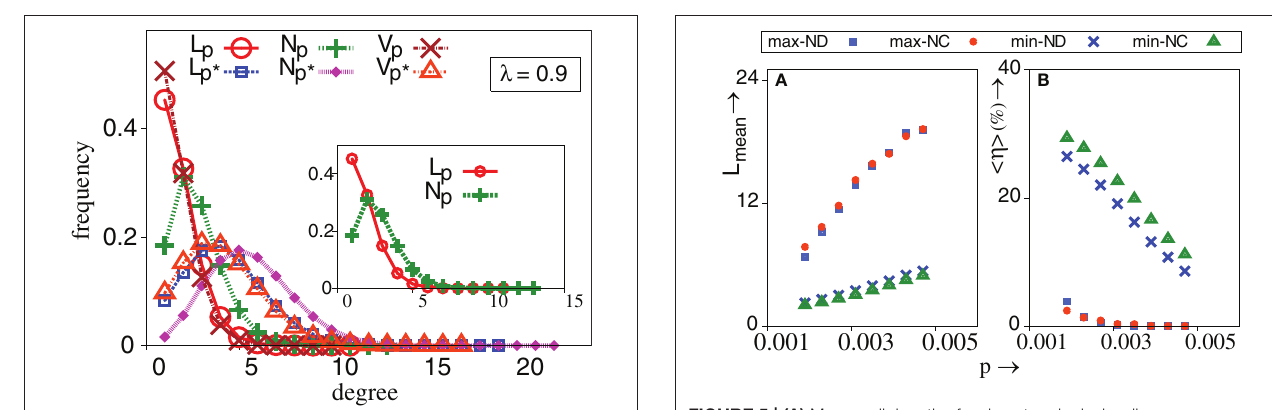
FIGURE 5 | (A) Mean walk length of various topological walks vs. p . (B) Percentage of ensemble averaged fraction of exhausted walks that fail to reach a local optimum vs. p . TIW are governed by minimum and maximum value of degree ( ND ) and closeness ( NC ) of nodes. λ = 0.9, N = 1024, N E = 1000. The standard error is smaller than the size of the data points. All other conditions are as in Figure 2F .